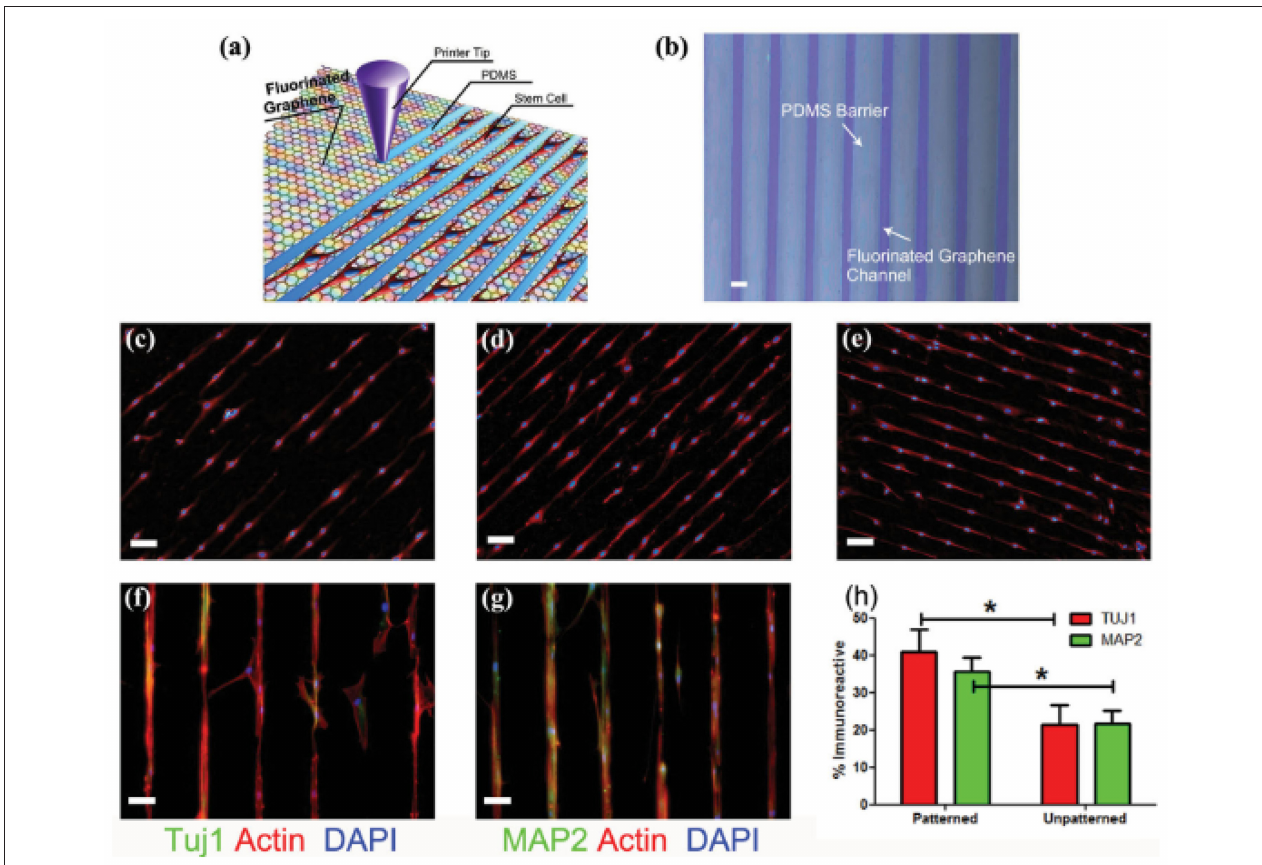
FIGURE 7 | (a) Schematic drawing of patterning MSCs by printing PDMS barriers on graphene films directly. (b) Optical microscope image of printed PDMS on fluorinated graphene film (scale bar = 50 µ m). (c–e) The aligned growth of stem cell on graphene, PFG and FG with printed PDMS pattern, respectively (scale bar = 100 µ m). (f,g) MSCs preferentially attached on the FG strips and their F-actin aligned (red) and expressed neural specific markers- Tuj1 and MAP2 (green) (scale bar = 50 µ m). (h) Percentage of immunoreactive cells for Tuj1 and MAP2 on unpatterned and patterned FG strips. Note that the patterned FG strips induce higher expression of Tuj1 and MAP2 in the absence of retinoic acid ( n = 6, p < 0.05). Reproduced with permission from Wang et al. ( 117). *signifies statistically significant differences between